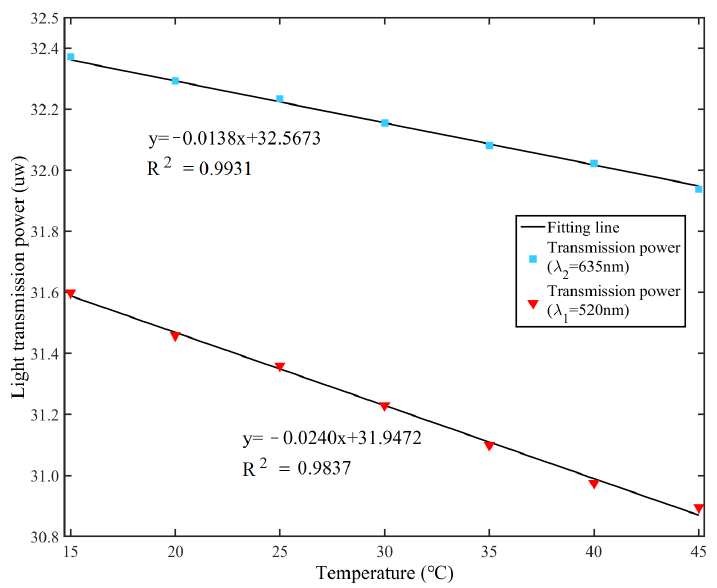
Figure 10. The output signal of dual wavelengths versus